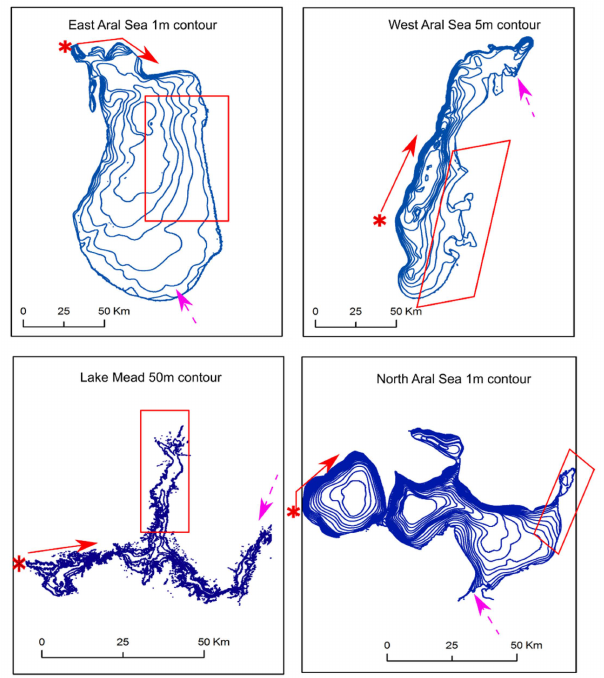
Figure 4. Contour of reservoirs; * starting point of boundary pixel collection; the red rectangle is the subsection of the reservoirs for selected area boundary pixels and the large magenta dashed arrow shows the mouth of the